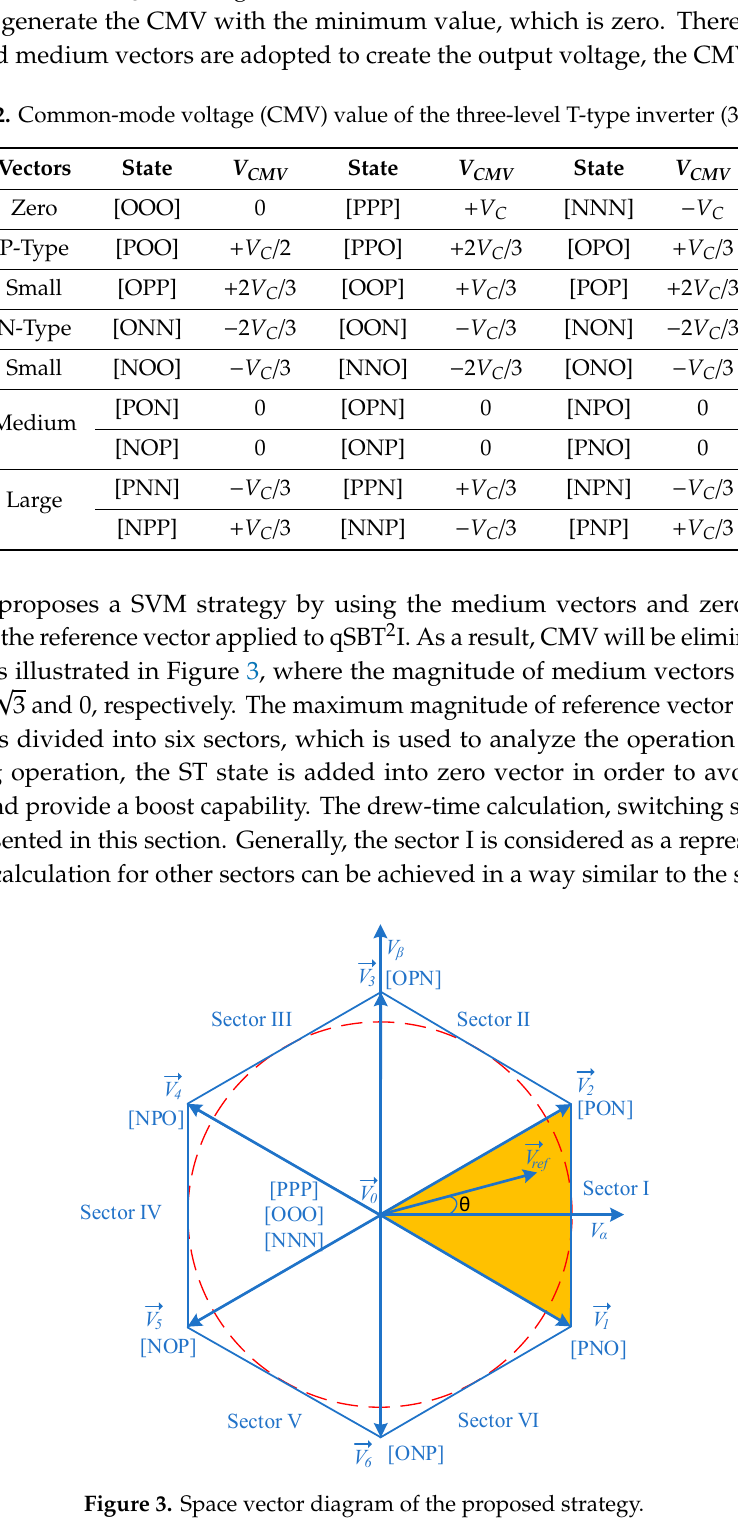
Figure 3. Space vector diagram of the proposed strategy.